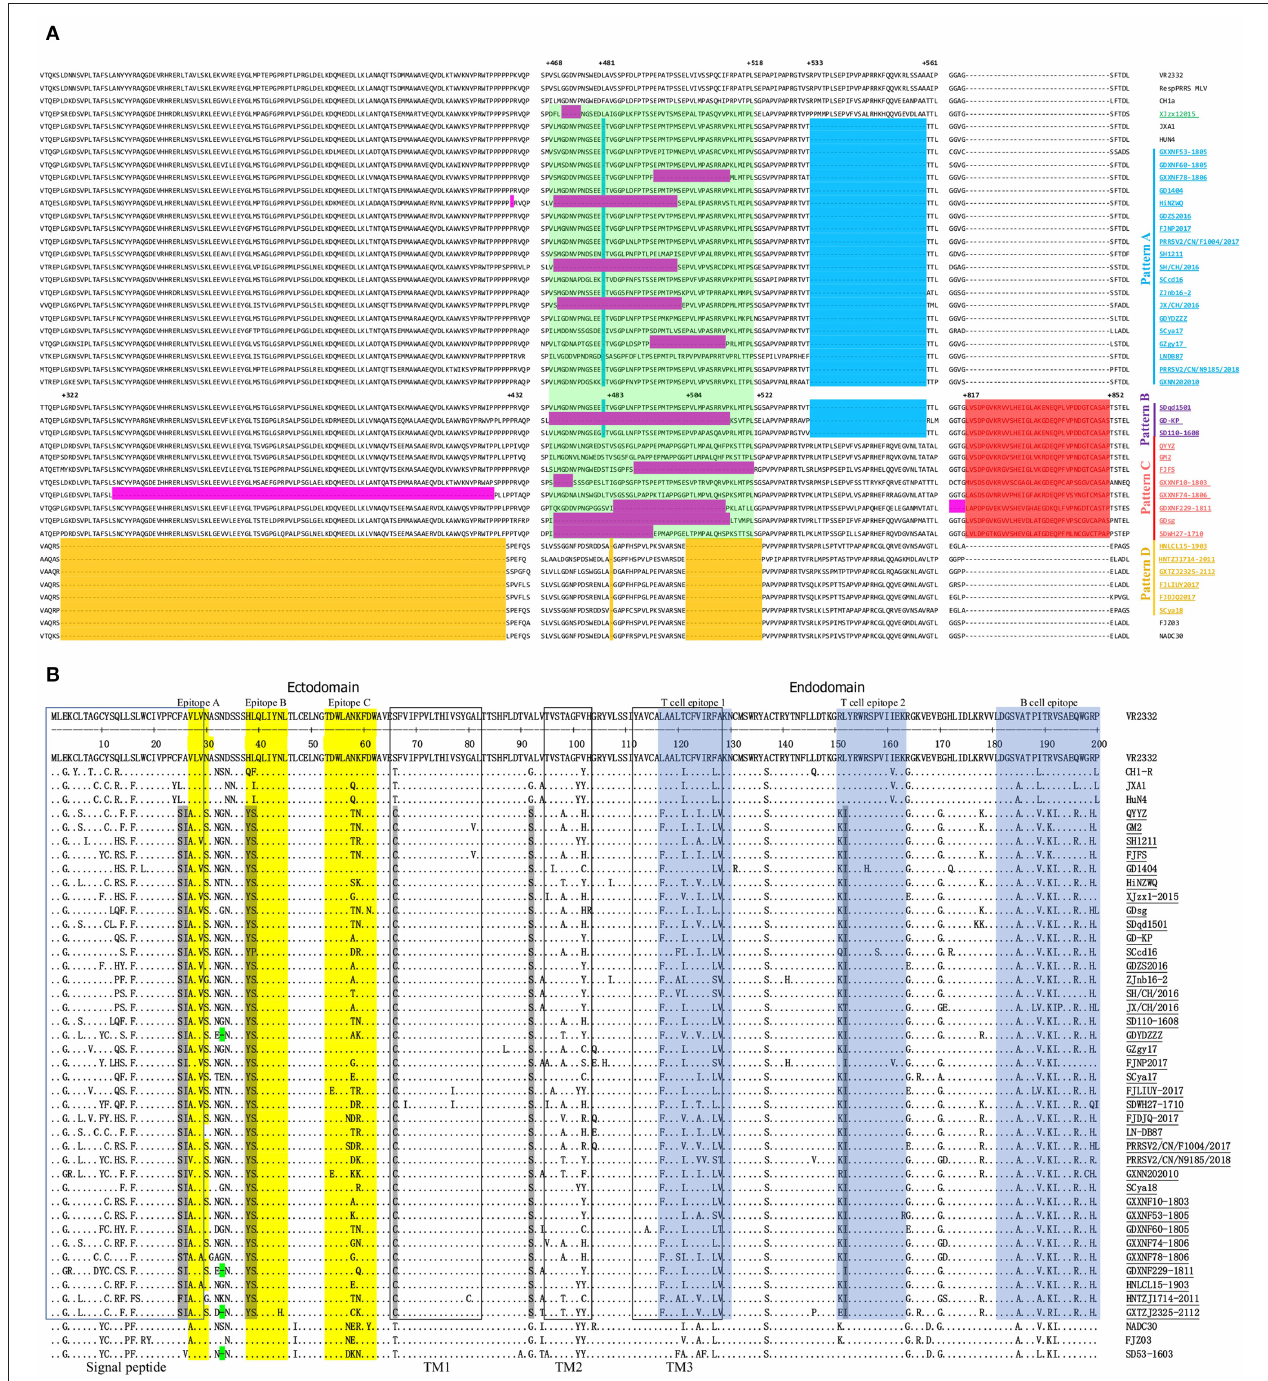
FIGURE 3 | Alignment of the deduced amino acid sequences among QYYZ-like PRRSVs. (A) The positions marked in the figure represent positions of the Nsp2 amino acid sequence and refer to the position of VR-2332. Red indicates the QYYZ strain 36-aa characteristic continuous insertion; yellow indicates the NADC30-like PRRSV 131-aa characteristic discontinuous deletion; blue indicates the HP-PRRSV 30-aa characteristic discontinuous deletion; and purple indicates some additional a deletions in QYYZ-like PRRSVs. (B) Alignment of the deduced amino acid sequence based on the ORF5 gene. The signal peptide and transmembrane (TM) regions are shown in blue and black boxes, respectively. The linear antigenic epitopes and cellular epitopes are indicated in yellow and blue, respectively. The seven amino acids characteristic of QYYZ-like strains are shown in gray.